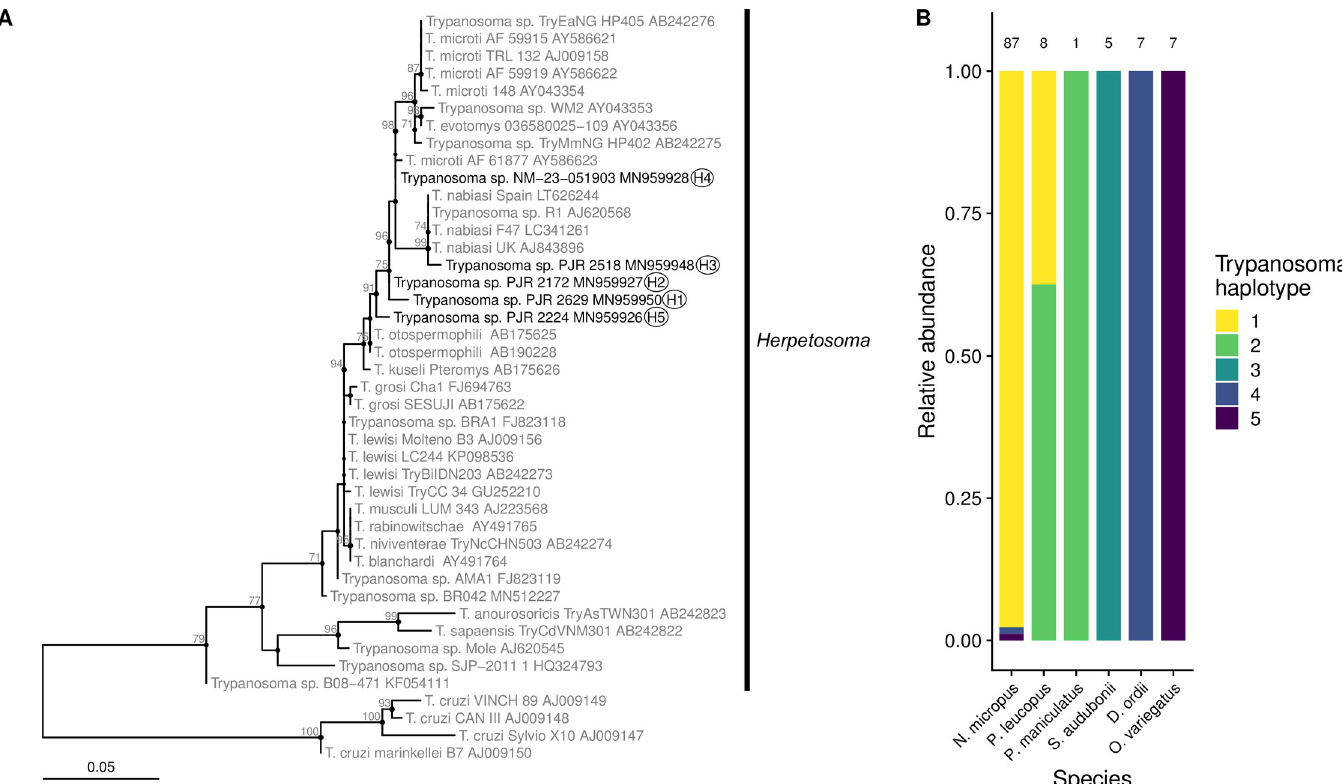
Fig 3. Phylogenetic tree and host associations of Trypanosoma haplotypes. (A) The maximum likelihood tree was produced from a 559 bp alignment (including gaps) of the 18S rRNA gene using the top model (TIM2+F+R2) following model selection with AICc in IQ-Tree. Reference sequences are colored gray and new haplotypes are colored black. Branch support values estimated from 1000 ultrafast replicates are shown next to branches if they were greater than 70%. Sequences representing T . cruzi were included as an outgroup to the other sequences in the Herpetosoma subgenus. Branch lengths are in units of the number of base substitutions per site. (B) The relative abundance of haplotypes identified in sampled animals are summarized for each positive host species. Numbers above the panel show the total Trypanosoma sequences obtained for each species.